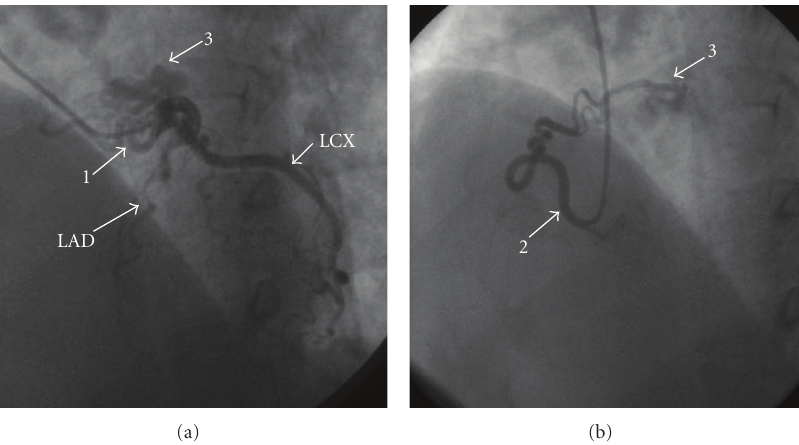
Figure 3: (a) The aberrant arteries from left anterior descending artery were detected with invasive coronary angiography. (b) The aberrant arteries from right coronary sinus were detected with invasive coronary angiography. LAD = left anterior descending artery, LCX = left circumflex artery, 1 = the aberrant artery from left anterior descending coronary artery, 2 = the aberrant artery from right coronary sinus, 3 = the network of the aberrant